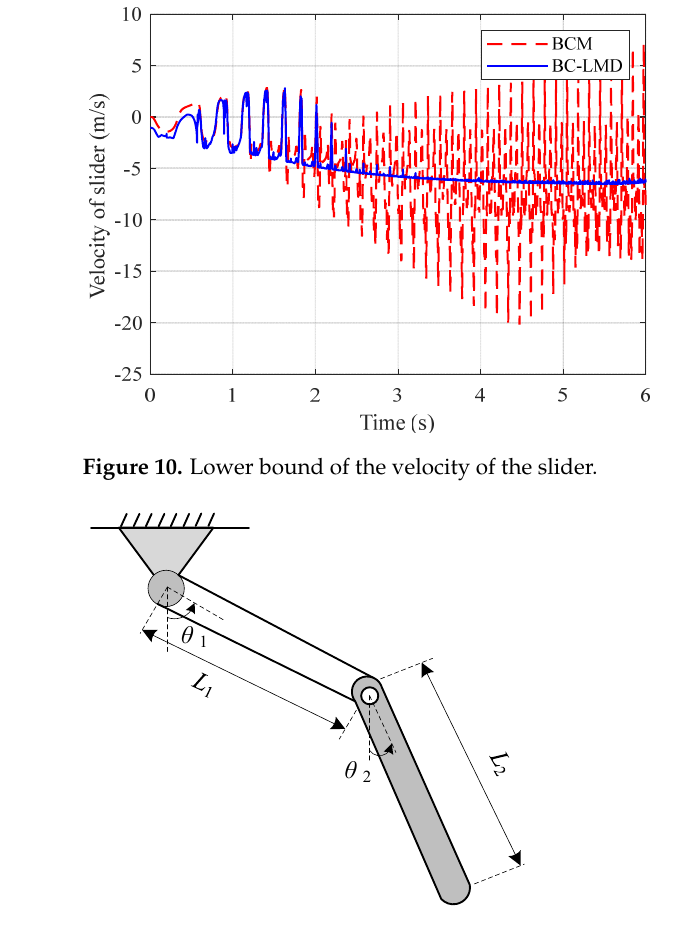
Table 2. Parameter of the double pendulum.